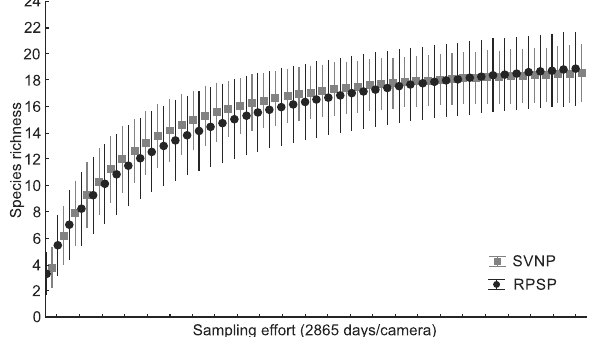
Figure 2. Species accumulation curve (richness x effort) and con- fidence interval (95%) in Rio Preto State Park (RPSP) and Sempre Vivas National Park (SVNP).